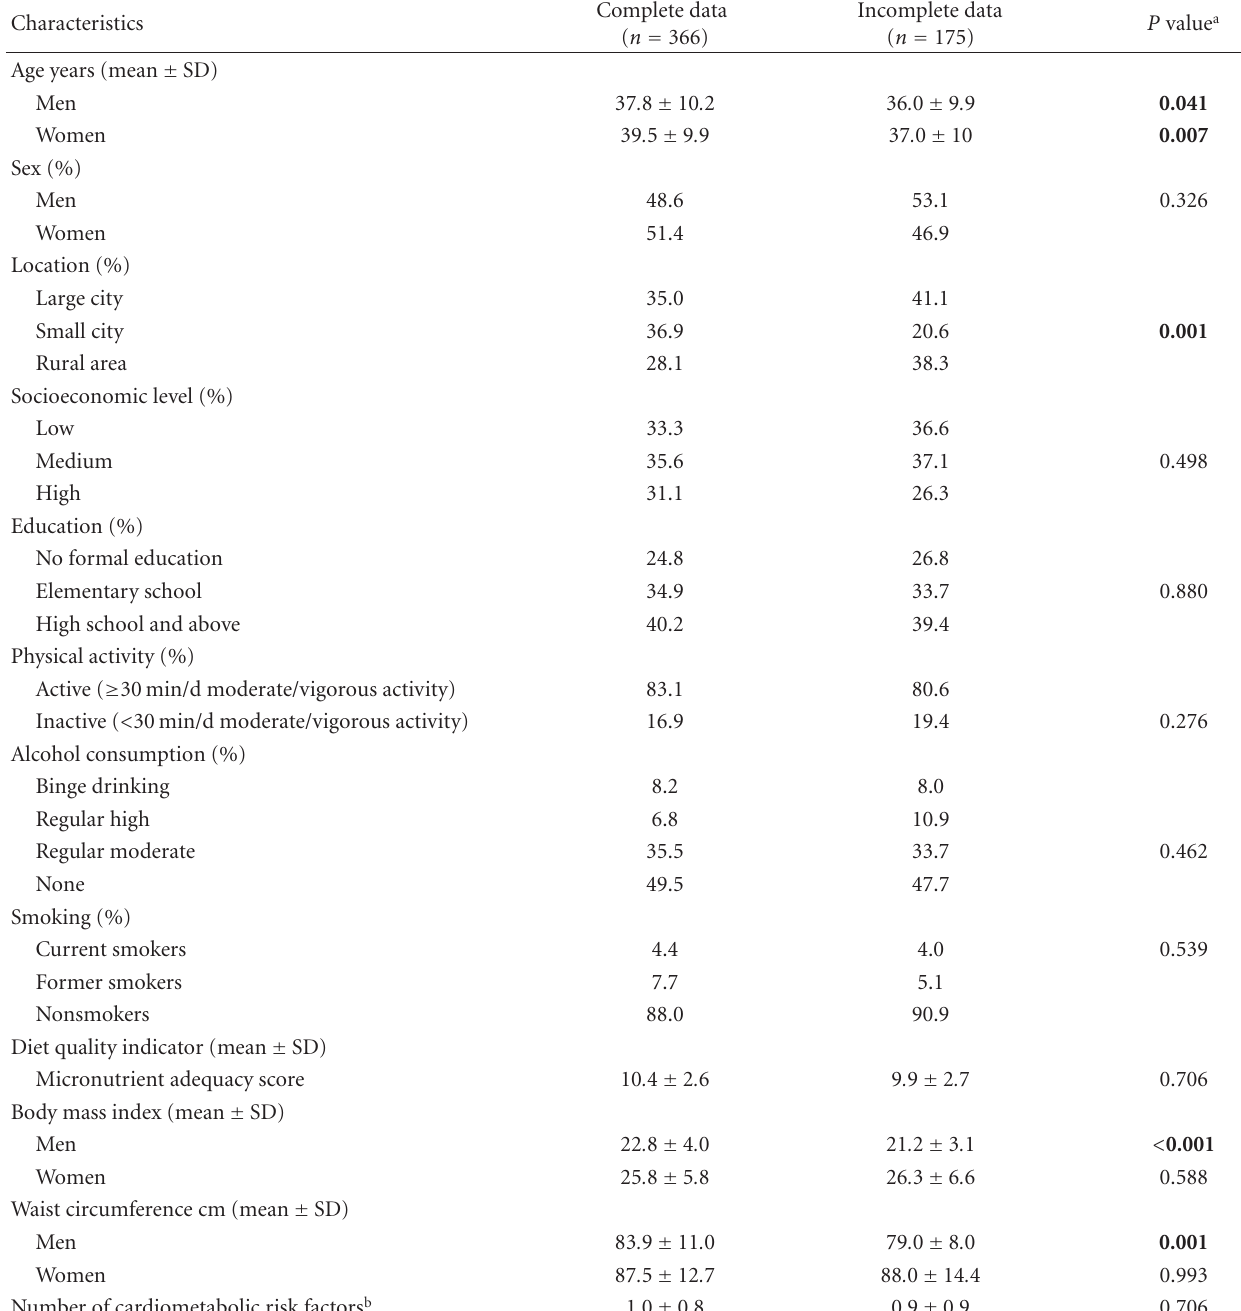
Table 1: Baseline characteristics of study subjects according to followup